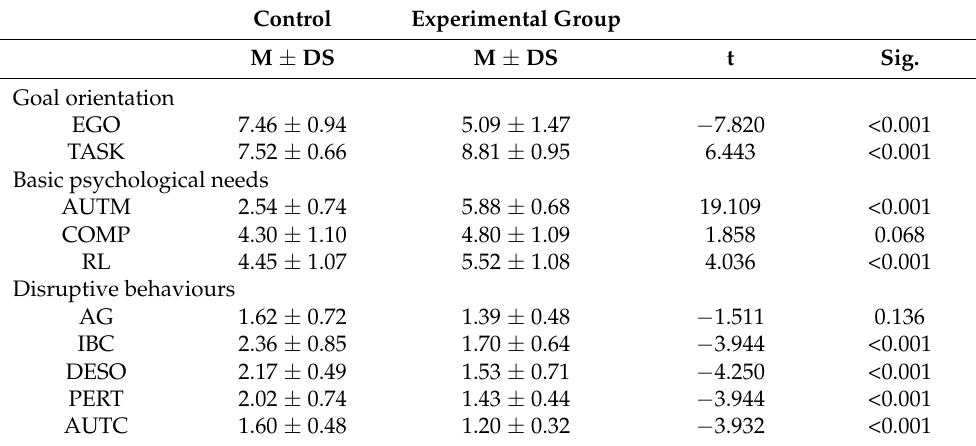
Table 3. Final results of the independent samples Student’s